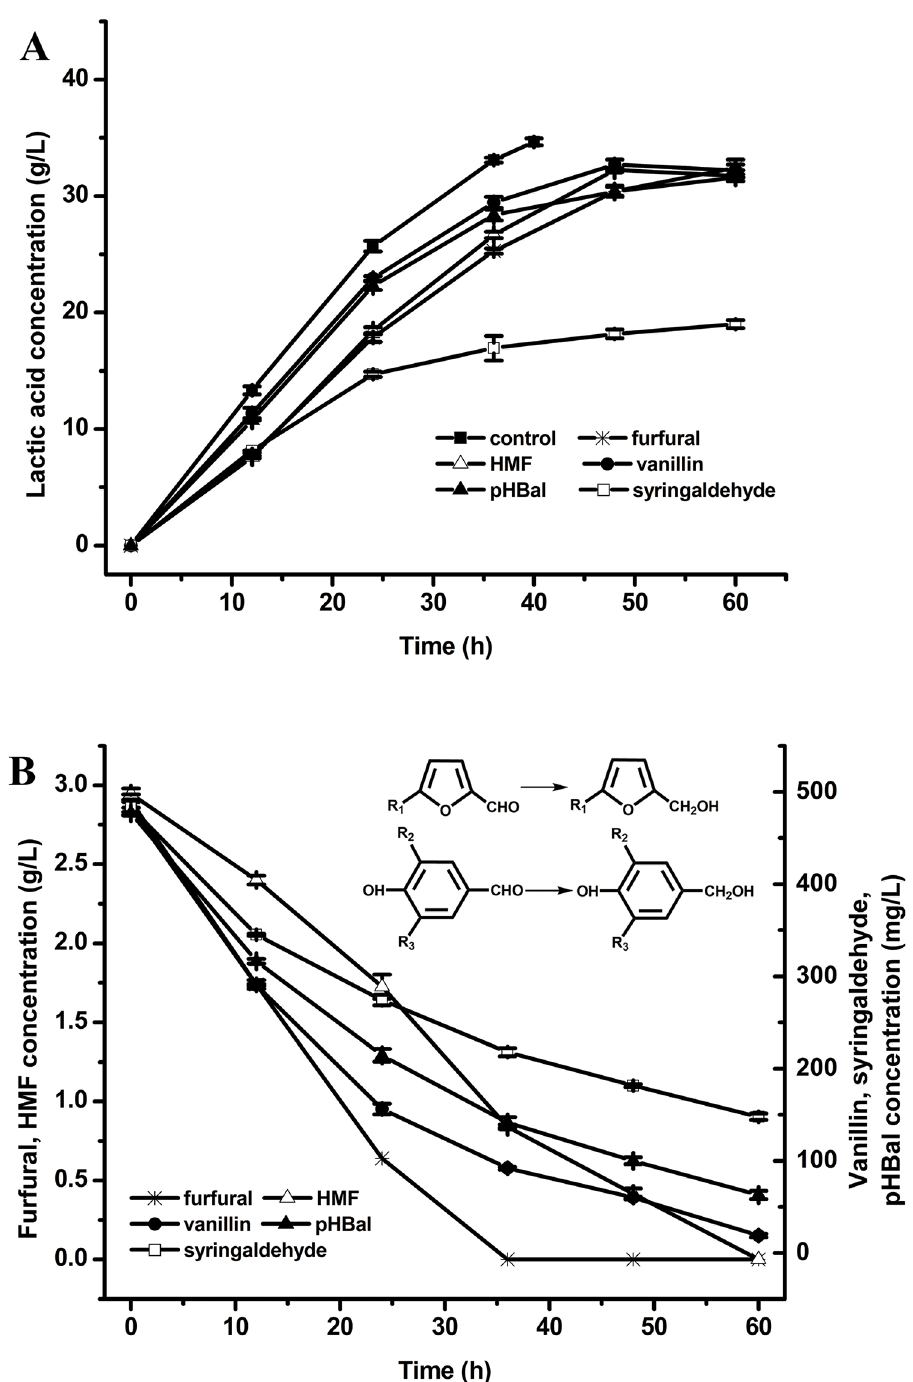
Fig 3. Fermentation performance of B . coagulans GKN316 in the presence of the individual inhibitors. ( A ) Lactic acid production; ( B ) Inhibitor concentration. R 1 = H, Furfural ! furfuryl alcohol; R 1 = CH 2 OH, HMF ! bis-hydroxymethylfuran (HMF alcohol); R 2 = H, R 3 = OCH 3 vanillin ! vanillyl alcohol; R 2 = R 3 = OCH 3 , syringaldehyde ! syringaldehyde alcohol; R 2 = R 3 = H, p -hydroxybenzaldehyde (pHBal) ! p -hydroxybenzyl alcohol. Values are the average ± SD of three separate